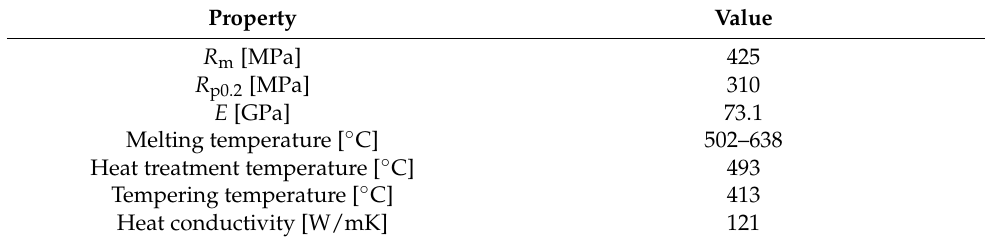
Table 3. Mechanical and physical properties of AA 2024-T351 [37].